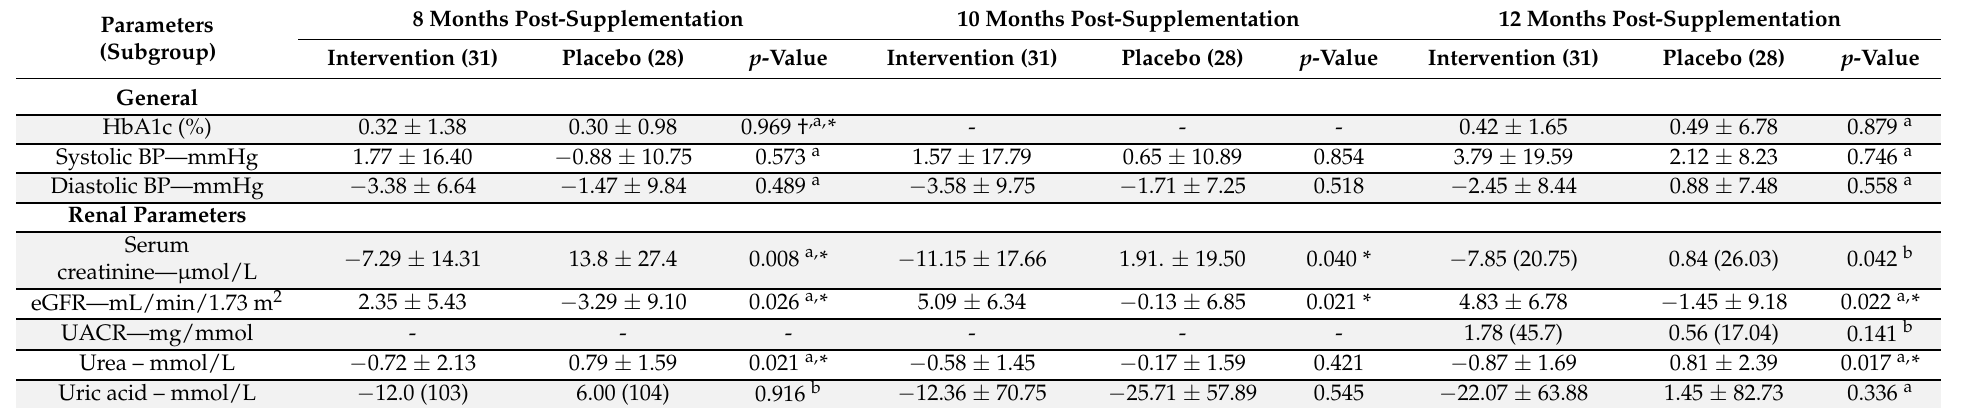
Table 6. Subgroup analysis comparing Tocotrienol-rich vitamin E supplementation between intervention and placebo group at 12